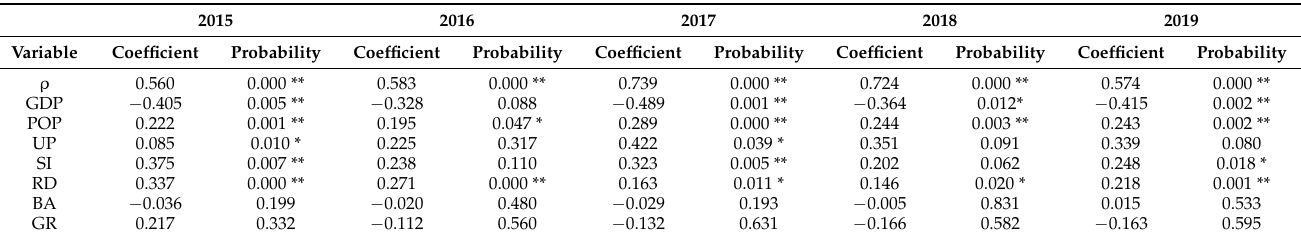
Table 3. Results of spatial lag